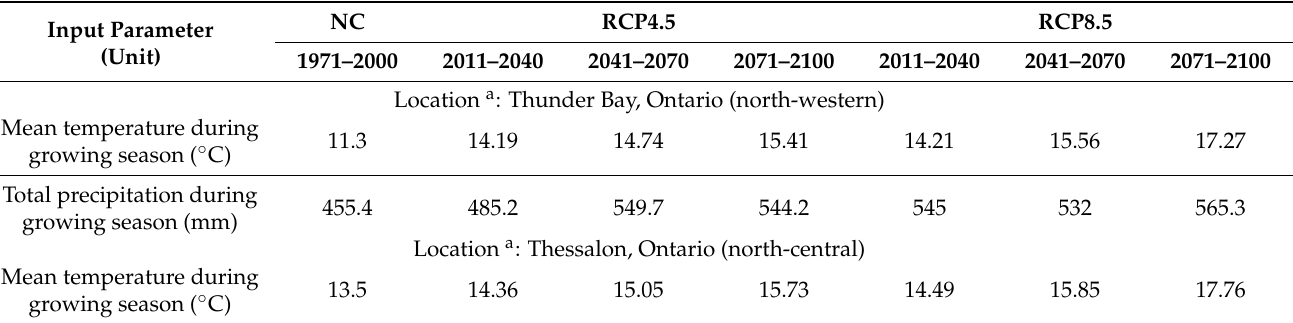
Table 1. Bioclimatic variables by commitment period, climate change scenario and geographical locale: observed historical climate norms (1971–2000; NC) and projected values consistent with the RCP4.5 and RCP8.5 climate change